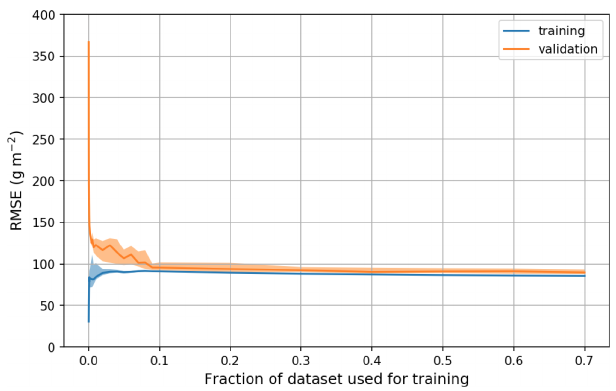
Figure 3. Learning curves for the LWP retrieval, showing the RMSE for the training and validation set with a varying training set size. Shaded areas correspond to the interquartile range calculated over 50 realizations of random splitting of the dataset into training and validation sets; bold lines are the